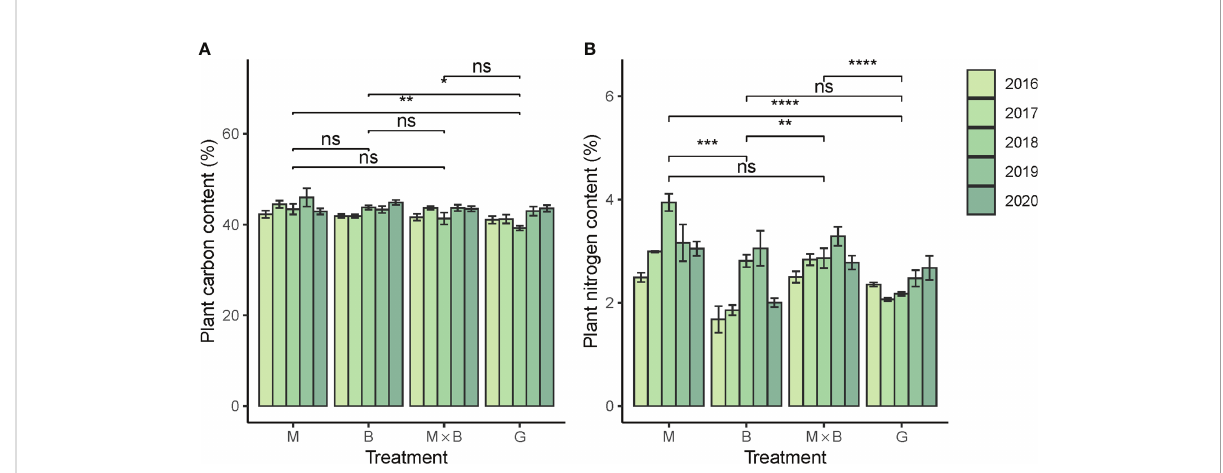
FIGURE 6 Year-to-year variations in plant carbon (A) and nitrogen (B) contents of alfalfa (M), smooth bromegrass (B) and the M×B mixture in comparison with a natural grassland (G) during the experimental period from 2016 to 2020. * p < 0.05, ** p < 0.01, *** p < 0.001, **** p < 0.0001, ns p > 0.05.